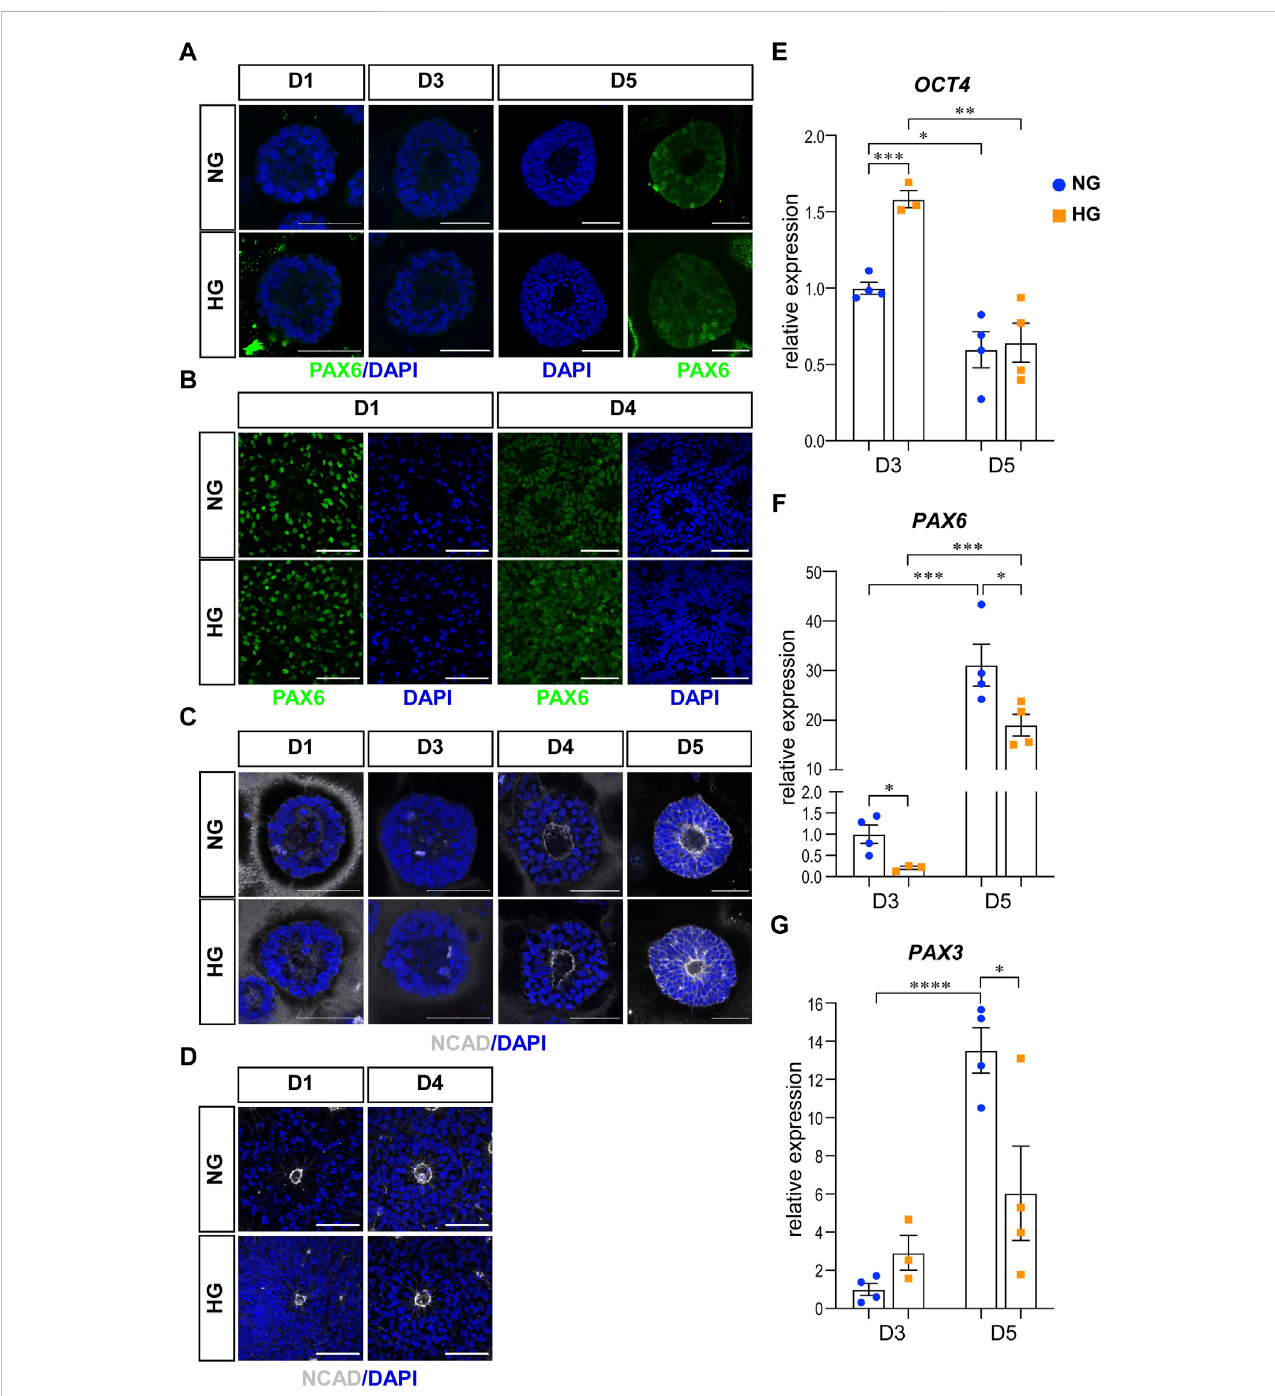
FIGURE 1 High glucose did not affect differentiation or polarity in either models. (A) Immuno fl uorescence images of PAX6 (green) in the normal (NG) and 2x high glucose (HG) groups at D1, 4, and 5 of the 3D neuroepithelial cysts. (B) PAX6 (green) staining in the normal (NG) and 2x high glucose (HG) groups at D1 and D4 after passage in rosette model. (C) Immuno fl uorescence images of NCAD (grey) at D1, 3, 4, and 5 of the 3D neuroepithelial cysts. (D) NCAD (grey) staining at D1 and D4 after passage in rosette model. All scale bar = 50 μ m. 3D neuroepithelial cysts were collected at either D3 or D5. Total RNA was extracted andsubjectedforqRT-PCR.N ≥ 3wells/condition.TherelativeexpressionlevelofeachgenewascalculatedtocomparetotheexpressionlevelinNGgroupat D3. The results for OCT4 (E) , PAX6 (F) , PAX3 (G) were presented in (E – G)